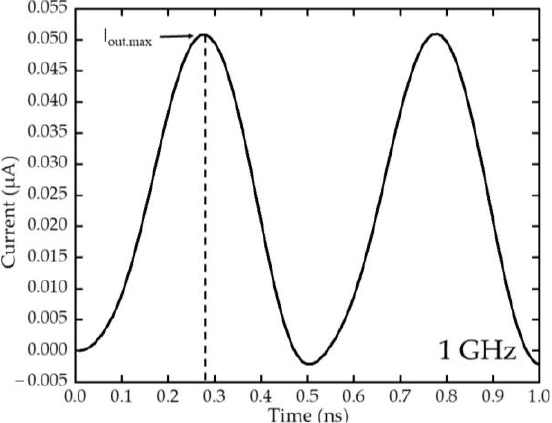
Figure 9. Maximum output current, I out.max from the rectified output DC current.